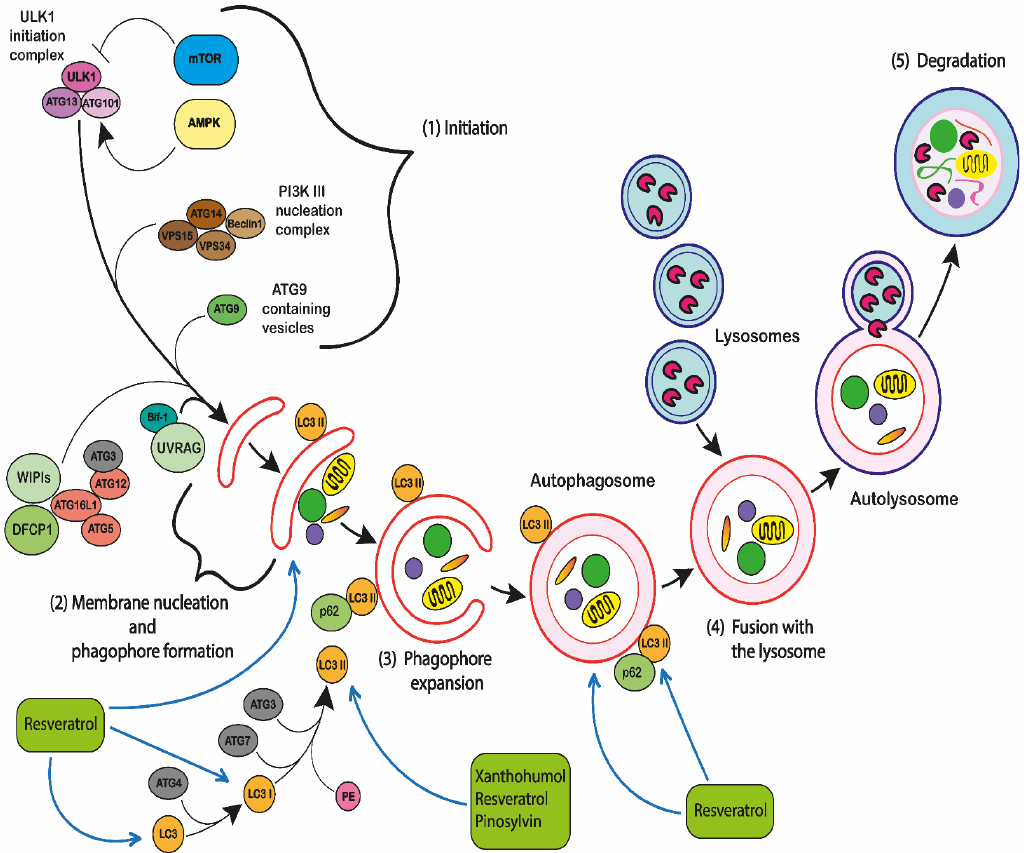
Figure 7. Stages and process of the autophagy. The process of the autophagy includes five stages (1) Initiation, (2) membrane nucleation and phagophore formation, (3) expansion of phagophore, (4) fusion with the lysosome, and (5) degradation. The autophagy initiation is mainly regulated by the mammalian target of rapamycin (mTOR) complex 1 mTOR (blue) as an inhibitor and AMP-activated kinase (AMPK) (light yellow) as an activator. The inhibition of mTOR and/or activation of AMPK leads to activation of the Unc-51-like kinase 1 (ULK1) complex (Purple), which includes ULK1, autophagy-related protein 13 (ATG13), and ATG101. This leads to triggering of the autophagy machinery and enables nucleation of the phagophore and regulated by three regulatory protein complexes. The class III PI3K (PI3KC3) complex (brown) involves vacuolar protein sorting 34 (VPS34), (VPS15), Beclin 1 and ATG14. The autophagosome-specific phosphatidyl-inositol-3-phosphate (PI3P)-binding complex (green) includes WD-repeat domain phosphoinositide-interacting proteins (WIPIs) and double FYVE domain-containing protein 1 (DFCP1). WIPIs then bind to ATG12-ATG5-ATG16L1 complex (light red), that in turn enhances the LC3 conjugation (orange). LC3 is converted into LC3-I by ATG4 (grey) and then conjugated with phosphatidylethanolamine (PE) (pink) and in the presence of ATG3 and ATG7 (grey) to form LC3-II, which is the characteristic signature of autophagosomal membranes. Different cellular membranes involve the elongation of the autophagosomal membrane such as the lipid bilayers, which are delivered by ATG9-containing vesicles (dark green). Now, the membrane of the autophagosomal seals around the structure are to be removed from the cell. The autophagosome fuses with the lysosome which destroys the contents. Finally, the autophagic cargo is degraded.